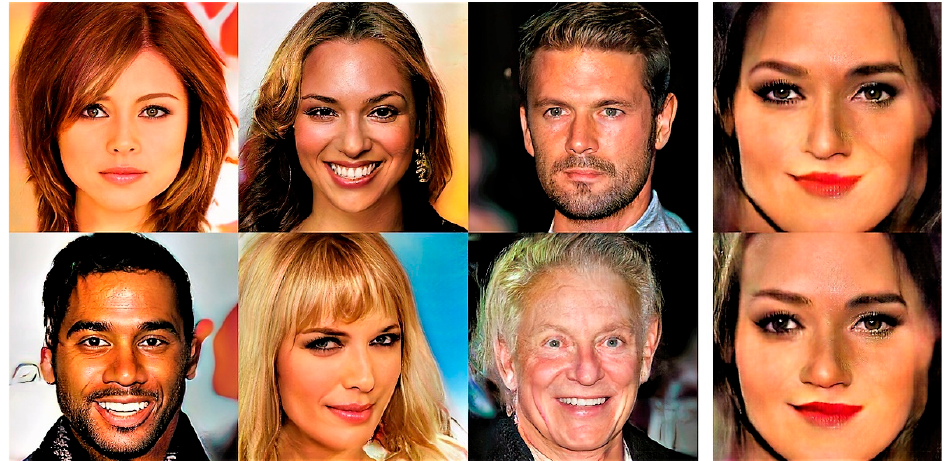
Figure 23. 1024 × 1024 resolution images generated by transfer learning. The rightmost column im- ages show those in the latent space of the model.